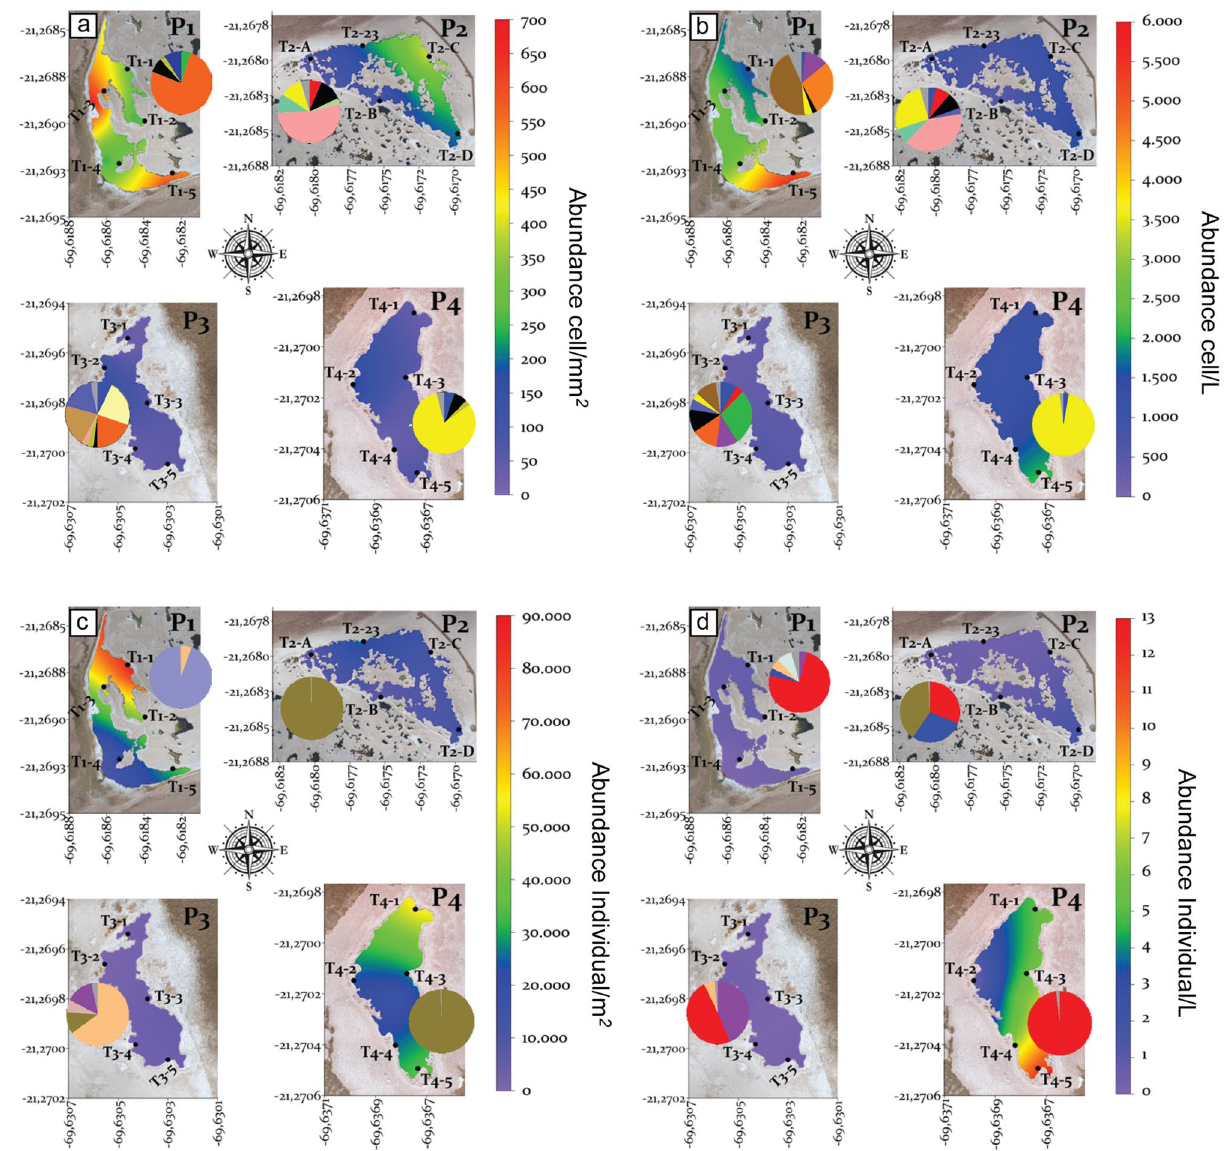
Figure 3. Abundances of the main biotic assemblages present in the bottom and water column of each puquio, with ranges defined by color bar legend to the right of each group: ( a ) phytobenthos, ( b ) phytoplankton, ( c ) zoobenthos and ( d ) zooplankton. Pie charts show the diversity and relative abundance of corresponding taxa within each lagoon. Main taxa are listed in decreasing order of abundance: ( a ) Phytobenthos; P1: Denticula, Achnanthidium , Fragilariaceae, P2: Staurosira, Staurosirella , Fragilariaceae, Nitzschia, P3: Denticula, Brachysira, Mastogloia , Cyanophyta, P4: Nitzschia, Achnanthidium , Fragilariaceae, ( b ) Phytoplankton; P1: Cyanophyta, Denticula , Campylodiscus , P2: Staurosira, Nitzschia, Staurosirella , Fragilariaceae, Amphora , P3: Brachysira, Denticula , Fragilariaceae, Campylodiscus , P4: Nitzschia, ( c ) Zoobenthos; P1: Gastropoda ( Heleobia ), Ceratopogonidae, P2: Ephydridae, P3: Ceratopogonidae, Arachnida, Ephydridae, P4: Ephydridae and ( d ) Zooplankton; P1: Branchiopoda ( Artemia ), Hexapoda, Ceratopogonidae, P2: Ephydridae, Branchiopoda ( Artemia ), Copepoda, P3: Branchiopoda ( Artemia ), Arachnida, Ceratopogonidae, P4: Branchiopoda ( Artemia ). Maps were generated using Surfer v13 https:// www. golde nsoft ware. com/ produ cts/